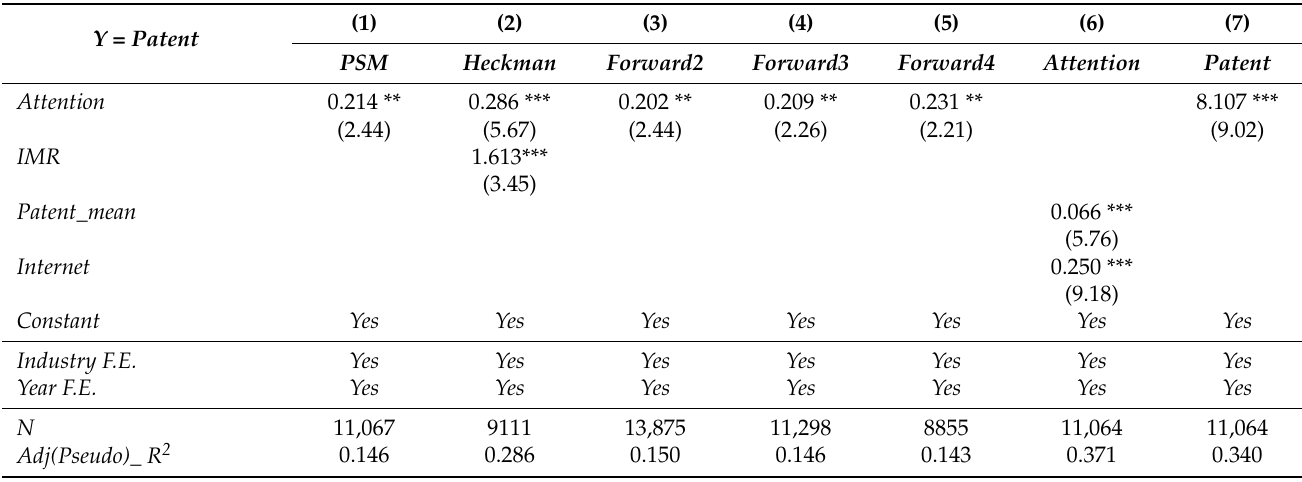
Table 6. Endogenous